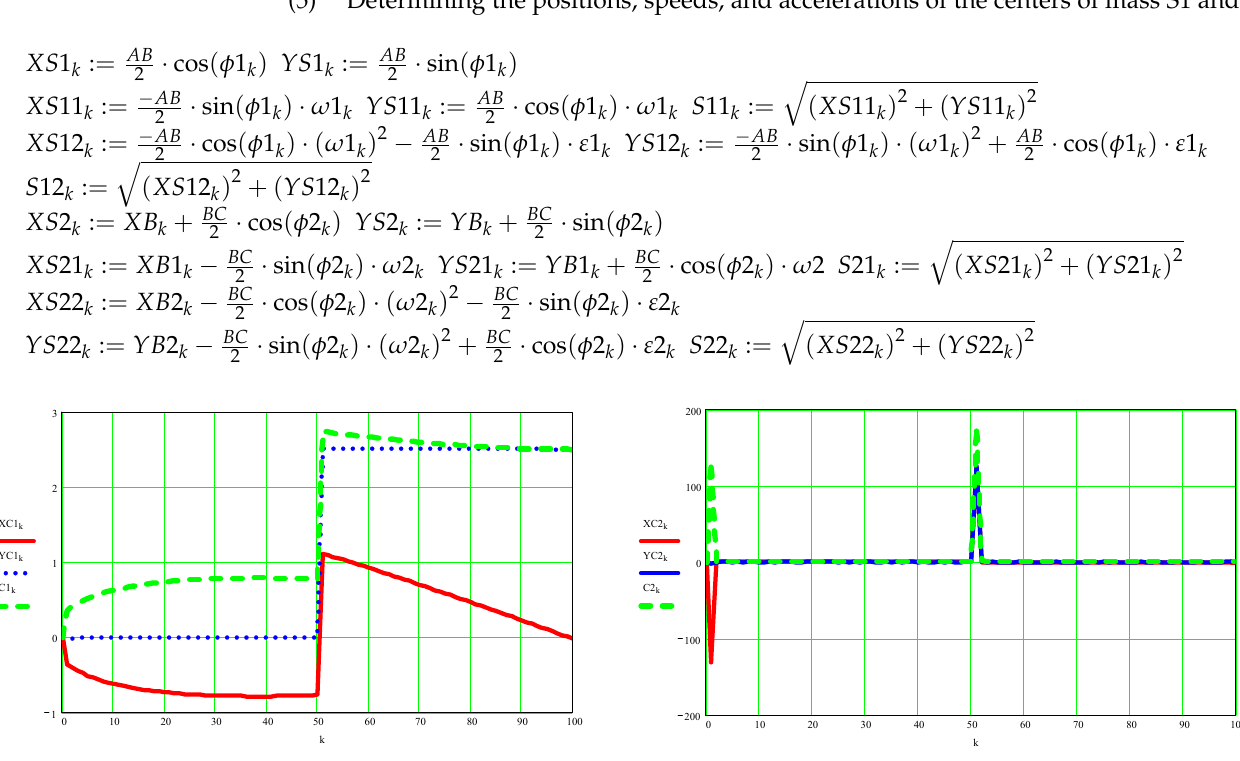
Figure A7. On the left side are the scalar coordinates of the speed of point C (red and blue) and its absolute speed (green); on the right the graphs of the accelerations of the same point C. Reverse kinematics on a 2R plane robot.